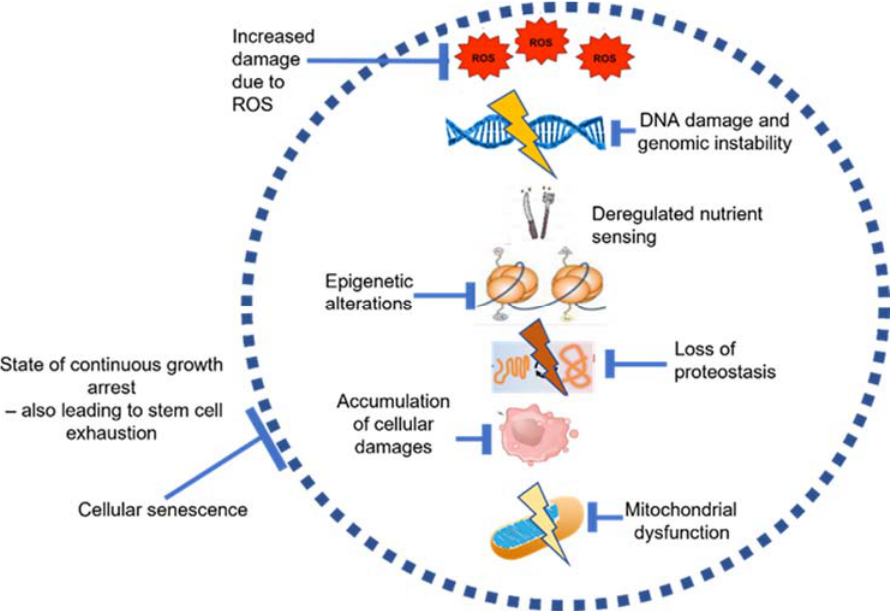
Figure 3. Underlying causes of aging inside the BM, recreated and adapted using information from Lopez Otin et al. [4] and González-Gualda et al. [31].